Question: Provide a one-line summary of what is displayed.
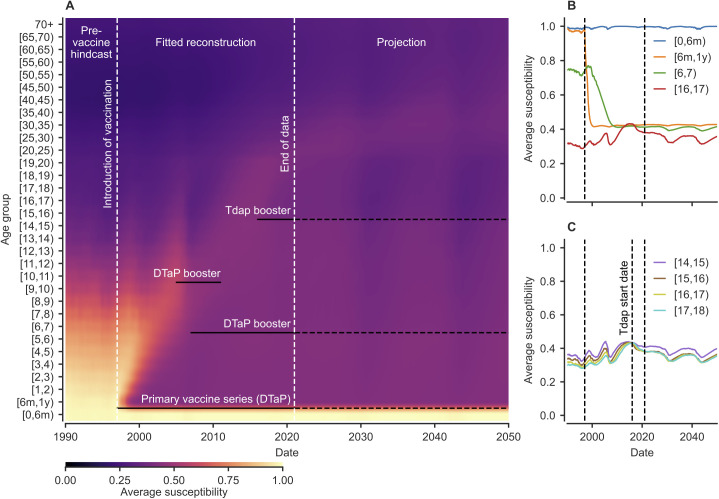
Answer: Reconstructed population-level susceptible profile. A) Average susceptibility of each age group in the full model by year. Average susceptibility is defined the proportion of each age group that either i) are immune naive or ii) have incomplete immunity, weighted by the vaccine protection parameter. Simulations are from a single representative replication using the maximum likelihood estimate for uncertain model parameters. Results are shown for three time periods: a pre-vaccination hindcast (before 1997), a fitted reconstruction during the period of data availability (1997–2020) and a projection from 2020 to 2050. For the post-2020 projection, covariates ( e.g., birth rate, vaccine schedule and uptake) are kept at their 2020 values. B) A slice of the average susceptibility through time for four age groups. C) A slice of the average susceptibility through time for four teenage age groups. In the model, the Tdap vaccine is administered as individual age from the [14, 15) to [15, 16) age group.